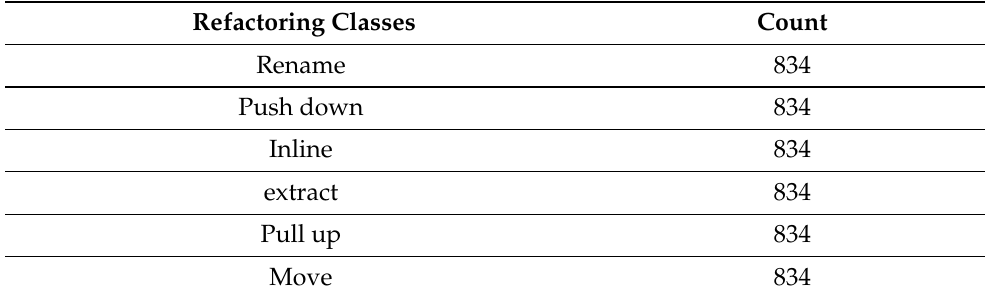
Table 2. Number of instances per class (Commit